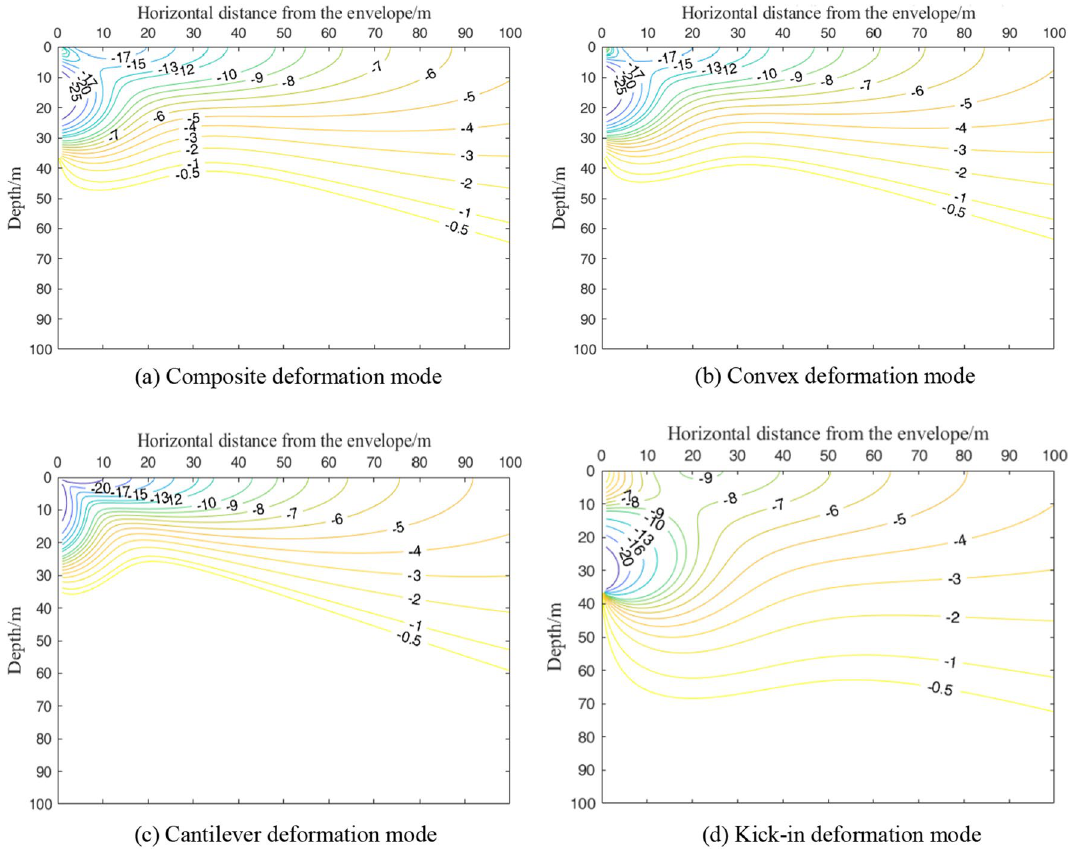
Figure 16. Contour map of maximum horizontal displacement of the tunnel under different deformation